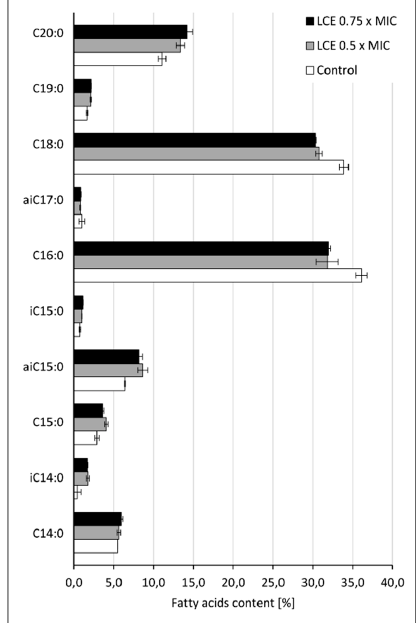
Figure 6. Composition of cell membrane fatty acids of control S. aureus 8325-4 cells or the cells treated with L. cardiaca L. extract (LCE) at 0.5 × MIC or 0.75 × MIC for 24 h, measured by HPLC–MS. iC / aiC—branched fatty acids with isomerism, respectively, iso / anteiso.